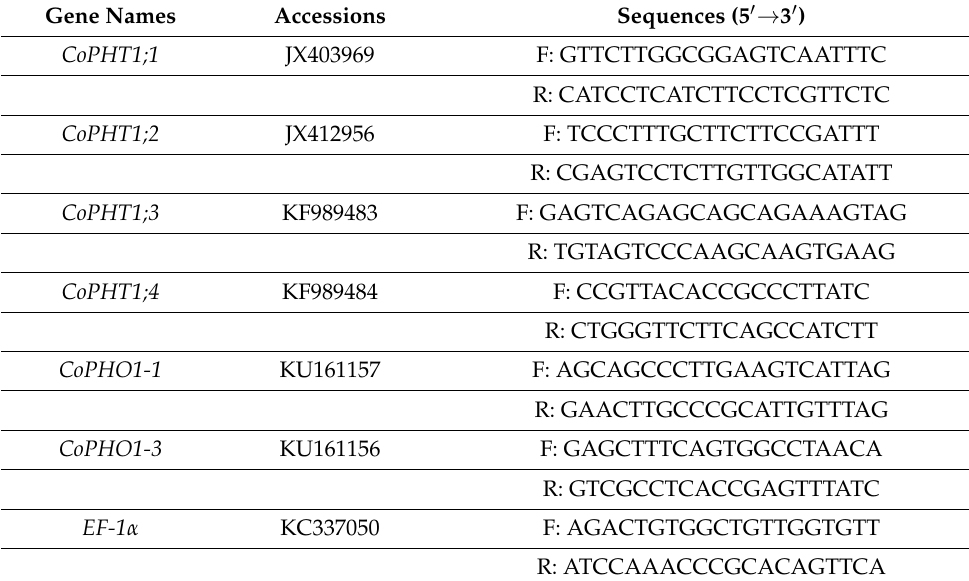
Table 1. The primer sequence of genes in